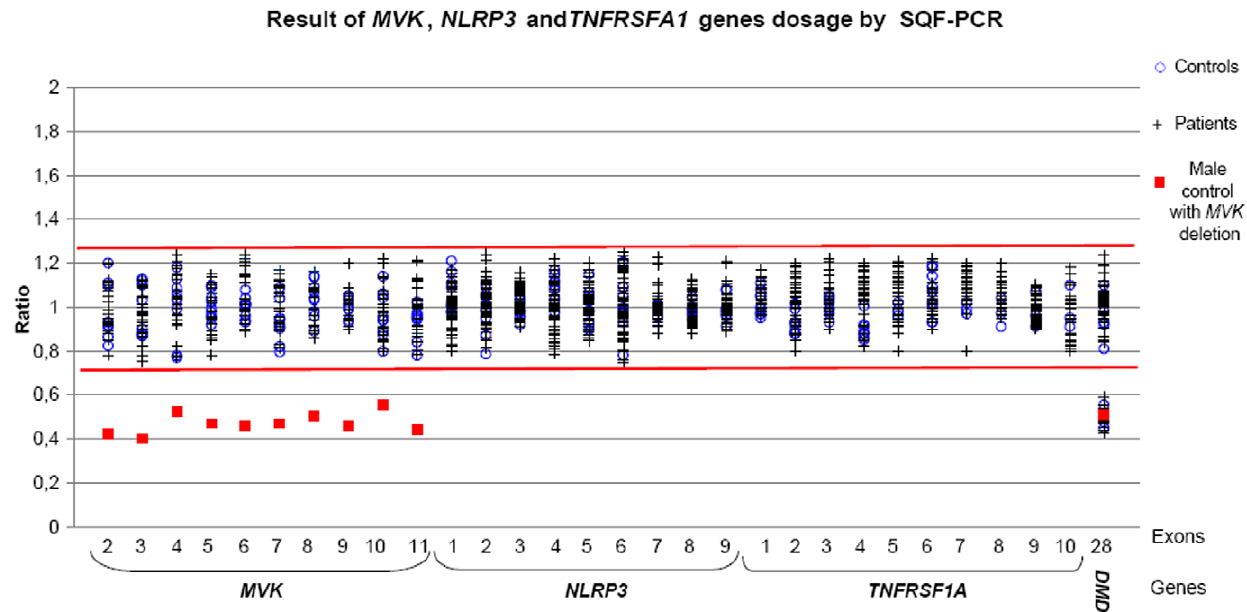
Figure 4. Results of MVK , NLRP3 and TNFRSF1A gene dosage analysis by SQF-PCR. We screened by SQF-PCR (i) all coding exons of the MVK gene in 9 controls, 1 DNA sample with a 12q23.2 deletion, and 28 patients (ii) all coding exons of the NLRP3 gene in 9 controls and 86 patients and (iii) all coding exons of the TNFRSF1A gene in 9 controls and 54 patients. target exon height or peak area = reference exon height or peak area ½ R ~ target exon height or peak area = reference exon height or peak area ½